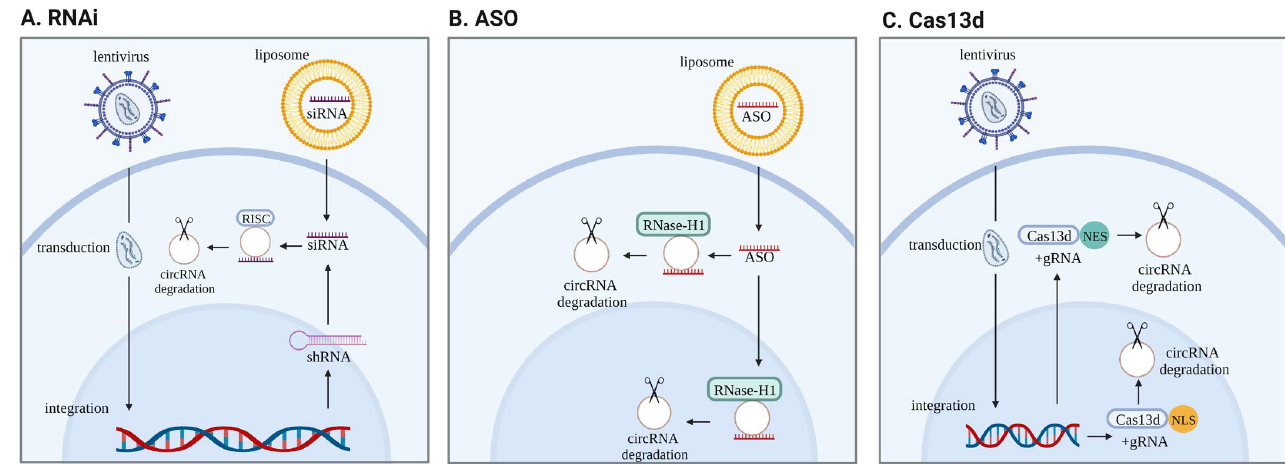
Figure 4. CircRNAs knockdown methods. ( A )—RNAi consists of two approaches: permanent reduction of expression with shRNA or temporary with siRNA. A lentivirus with a plasmid containing shRNA integrates into the genome. In both methods, the functional molecule is a siRNA that binds complementarily to the target and causes its deterioration. ( B )—ASO can act in both the cytosol and nucleus, and, by creating a DNA/RNA hybrid, leads to the degradation of a specific molecule via RNase-H1. ( C )—A plasmid containing Cas13d and gRNA is delivered via a lentivirus into the cell and integrated into the genome. Cas13d can include either a NLS tag to localize in the nucleus or NES to localize mainly in the cytosol. Due to a specific gRNA, Cas13d attaches to a particular molecule and induces its degradation.